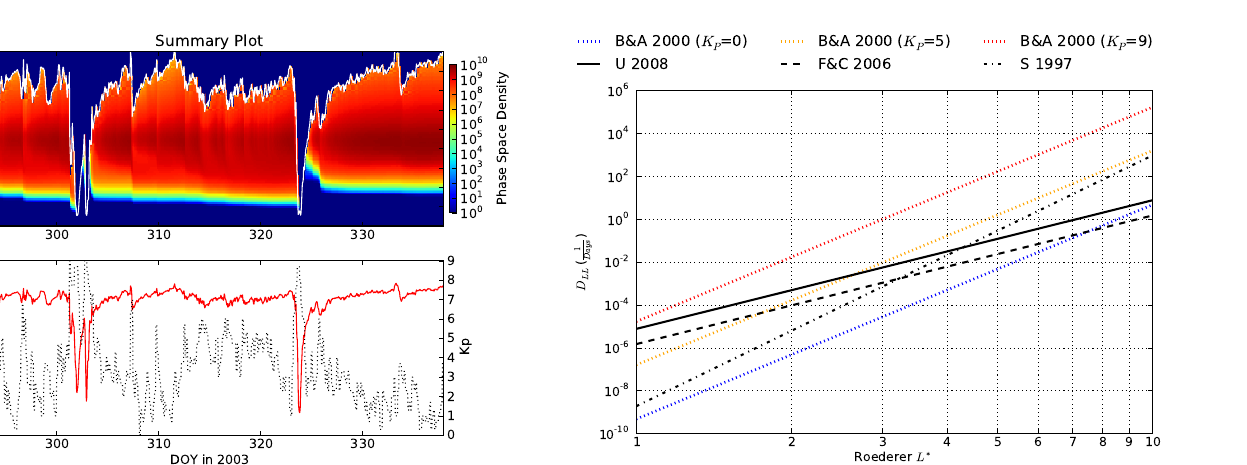
Fig. 1. Example output from a RadBelt simulation of the well known “Halloween Storms”. The top frame shows phase space den- sity with L max location over plotted in white. The bottom frame shows the geomagnetic indices used to drive D LL and the empiri- cal source and loss functions.